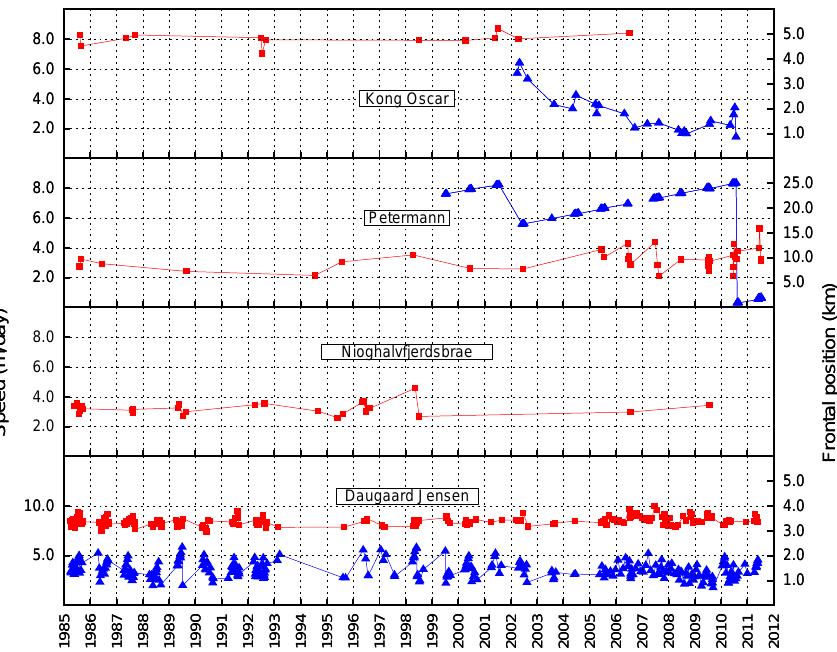
Fig. 7. Surface flow speeds (red squares) and frontal positions (blue triangles) for the Kong Oscar, Petermann, Nioghalvfjerdsbrae and Daugaard-Jensen glaciers (see Fig. 1 for